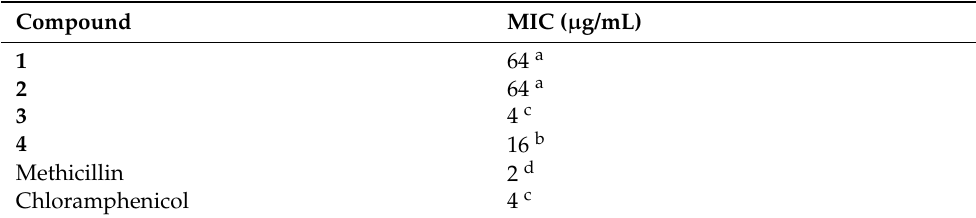
Table 3. In vitro antibacterial activity of the isolated flavonoid glycosides.